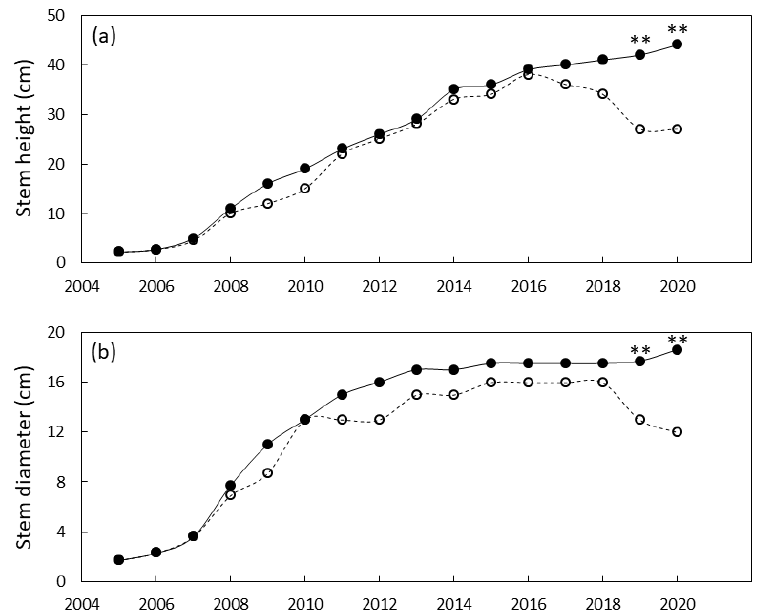
Figure 6. Size of Cycas micronesica plants growing in a north Guam garden over a 15 y growth period. ( a ) stem height and ( b ) basal stem diameter. Closed circles are local genotypes, open circles are foreign genotypes. ** = significant at p ≤ 0.01.